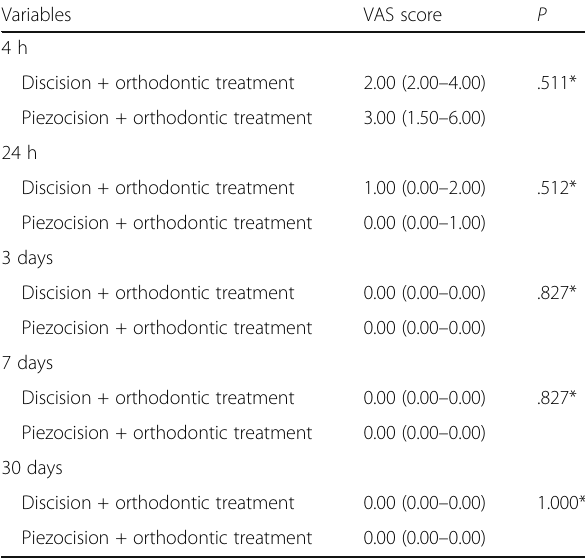
Table 5 Comparison of mandibular VAS scores within experimental groups after the accelerated procedures according to different observation periods Variables